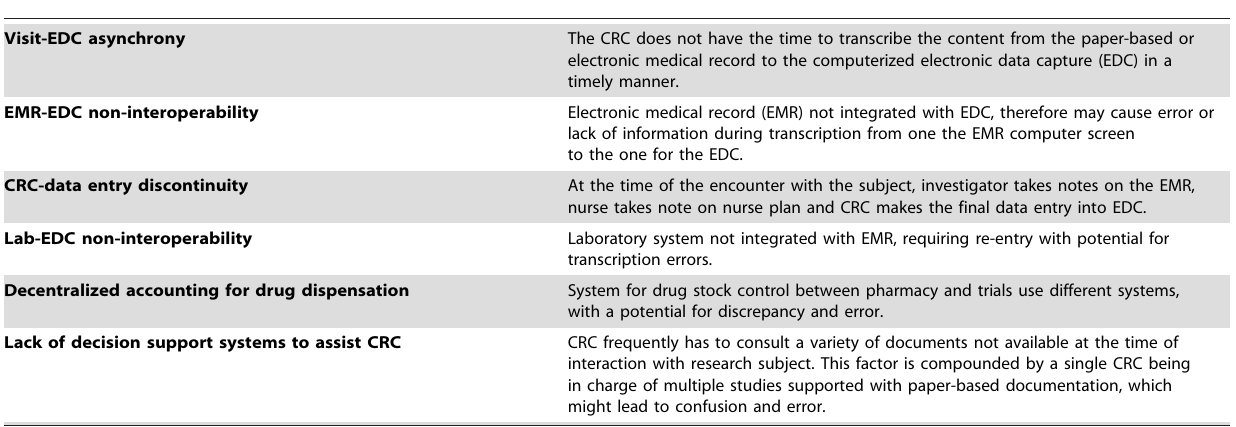
Table 2. Variables classified as problematic on visited sites.